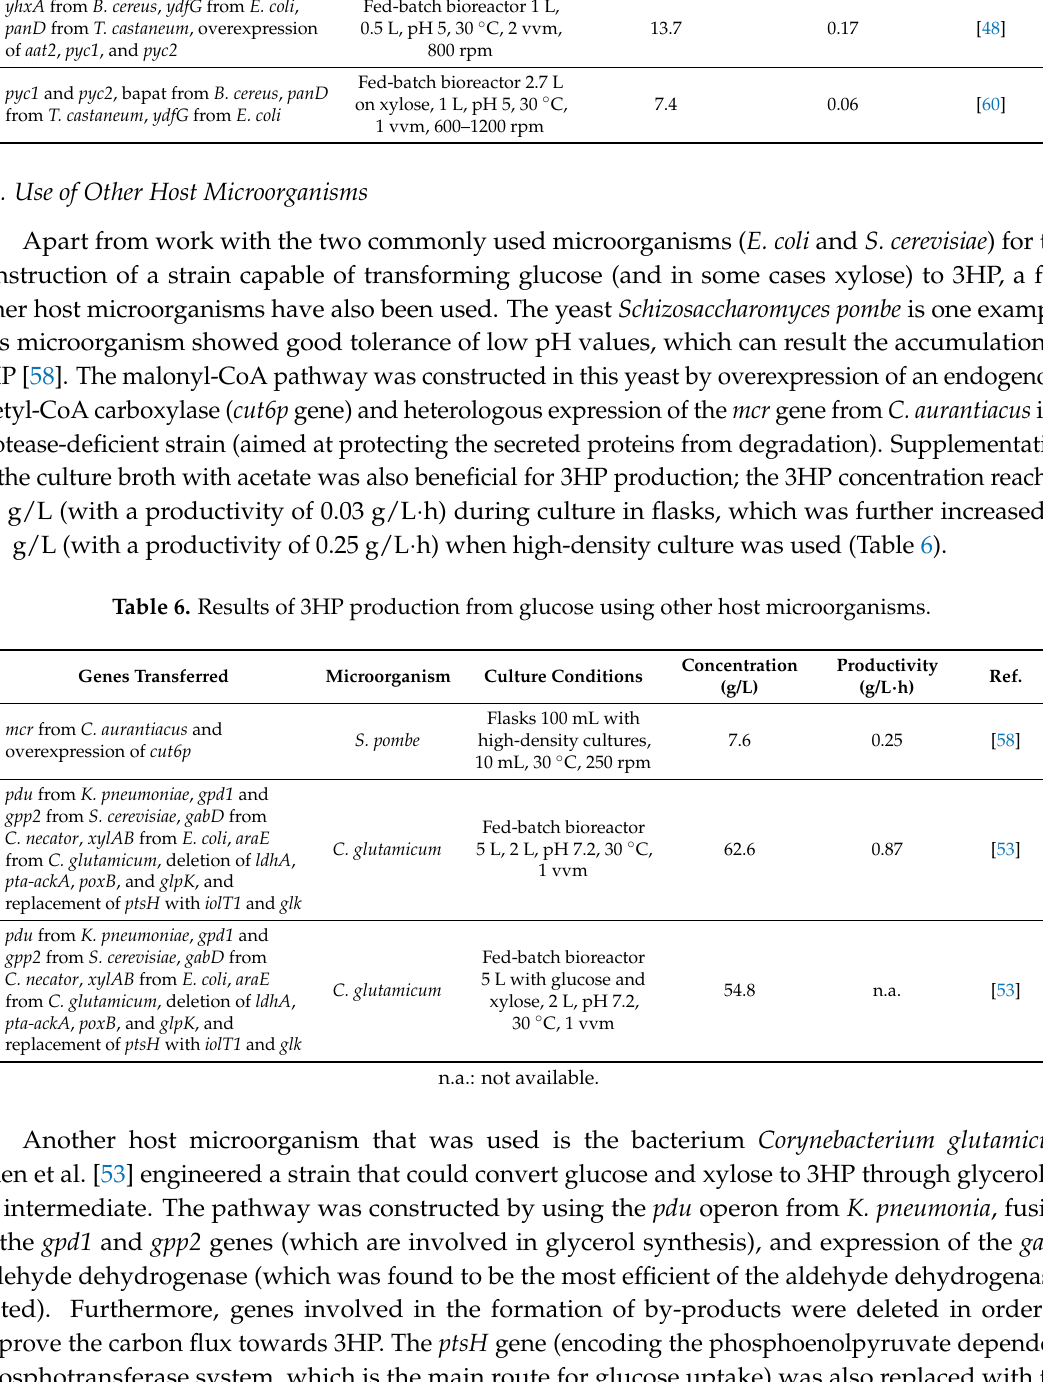
Concentration Productivity Ref. (g/L) (g/L · h)